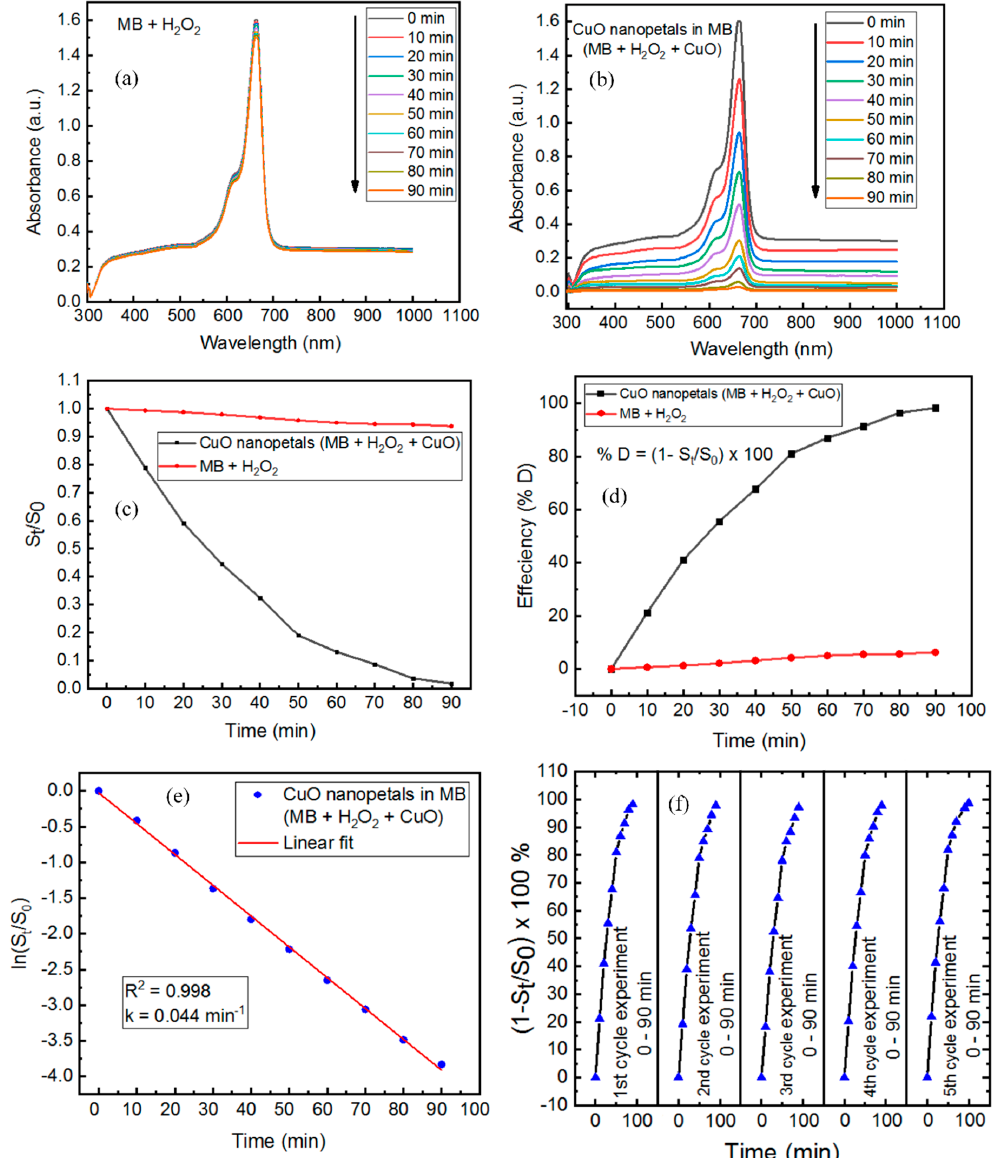
Figure 9. UV–visible absorption analysis for degradation of methylene blue dye solution in the presence of hydrogen peroxide and CuO nanopetals under dark at room temperature. ( a ) Degradation of MB solution in the presence of H 2 O 2 without addition of any CuO nanopetals. ( b ) Degradation of MB solution in the presence of H 2 O 2 + CuO. ( c , d ) Spectrum of the concentration ratio of MB + H 2 O 2 and MB + H 2 O 2 + CuO versus specific time intervals, respectively. ( e ) First-order kinetic (linear) plot, ln(S t / S o ) versus t (time). ( f ) The degradation e ffi ciency of MB dye in the presence of H 2 O 2 + CuO for the five times repeated process. The reaction mechanism of the fast degradation of methylene blue with the support of hydrogen peroxide and CuO nanopetals without using any external source of irradiation with photon proceeds according to the following [45].